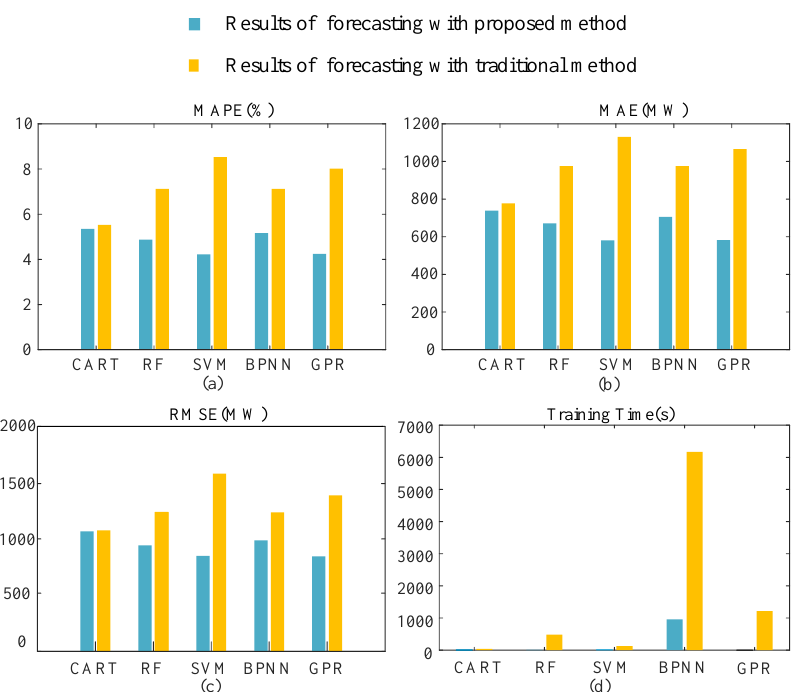
Figure 9. Comparison of error and time of training a model with traditional and proposed approaches.